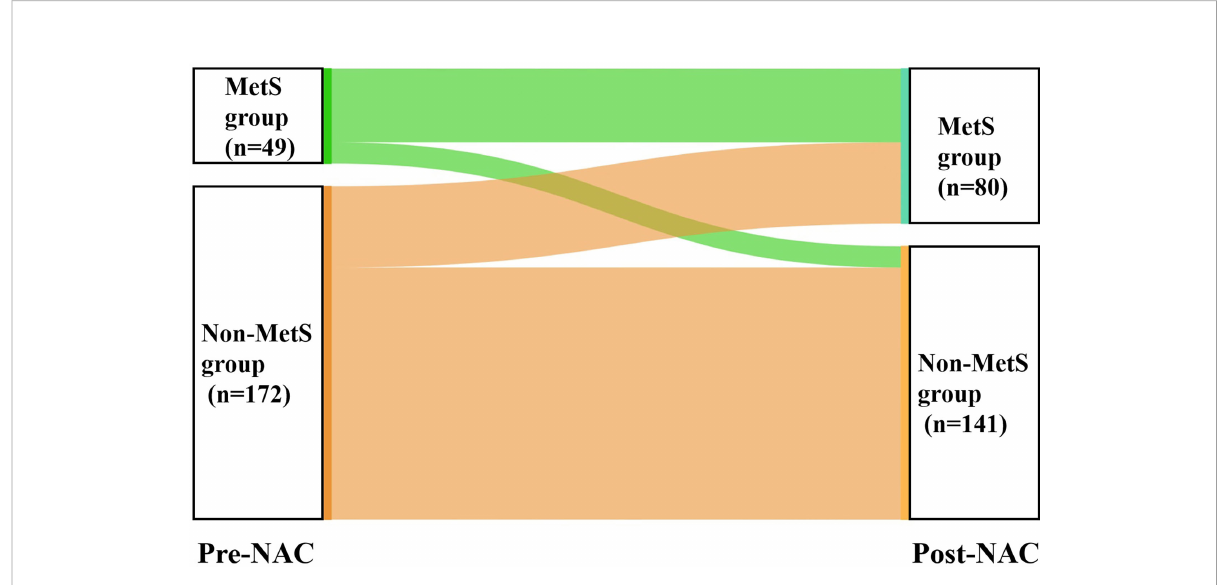
FIGURE 2 Changes in MetS status before and after NAC. MetS, metabolic syndrome; NAC, neoadjuvant